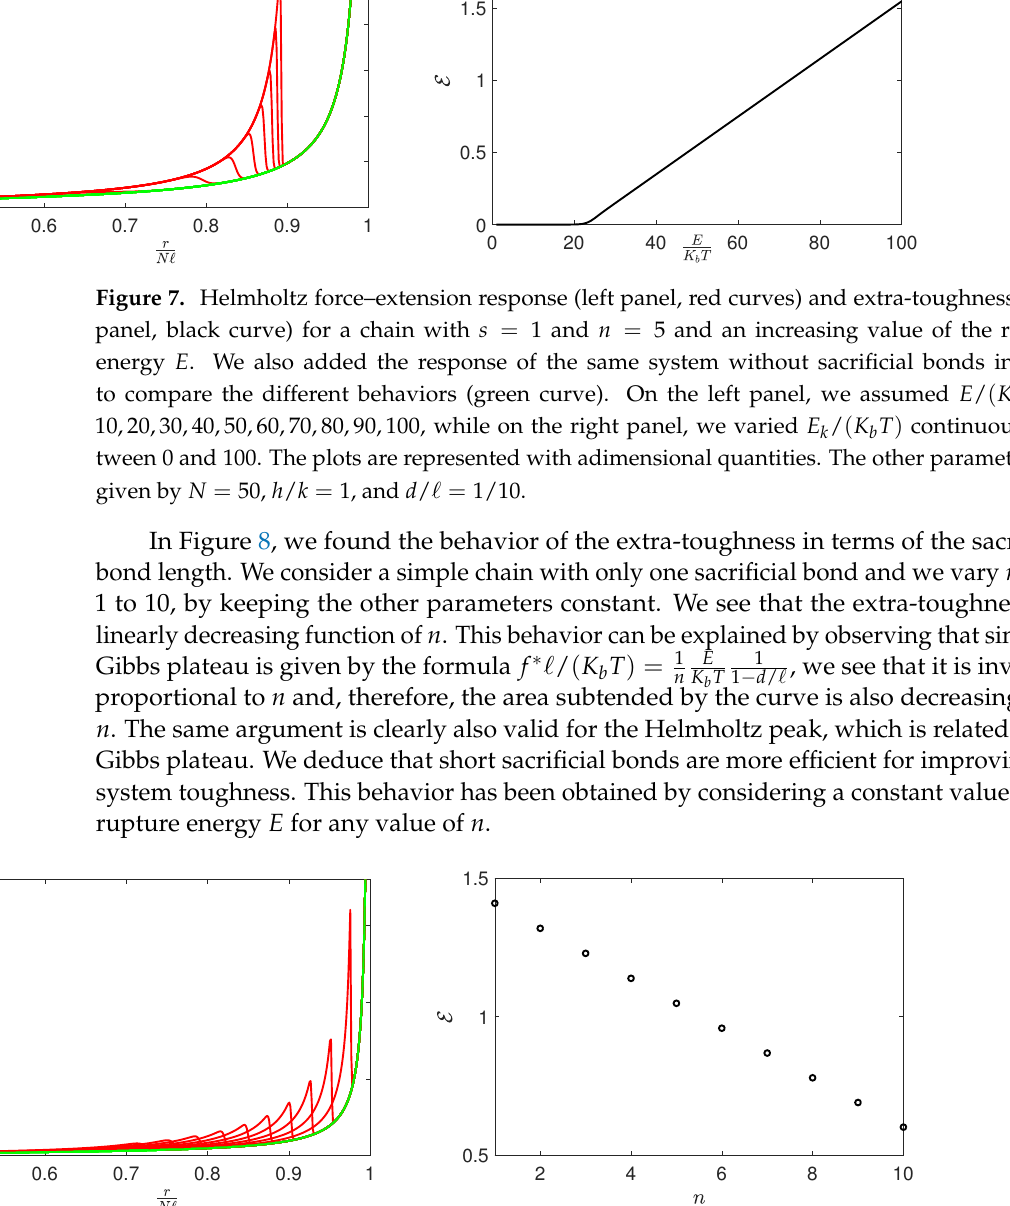
Figure 8. Helmholtz force–extension response (left panel, red curves) and extra-toughness (right panel, black symbols) for a chain with s = 1 and an increasing length n of the sacrificial bond. We also added the response of the same system without sacrificial bonds in order to compare the different behaviors (green curve). We assumed n = 1,2, 3,...,10. The plots are represented with adimensional quantities. The other parameters are given by N = 50, h / k = 1, E / ( K b T ) = 75 and d / (cid:96) =